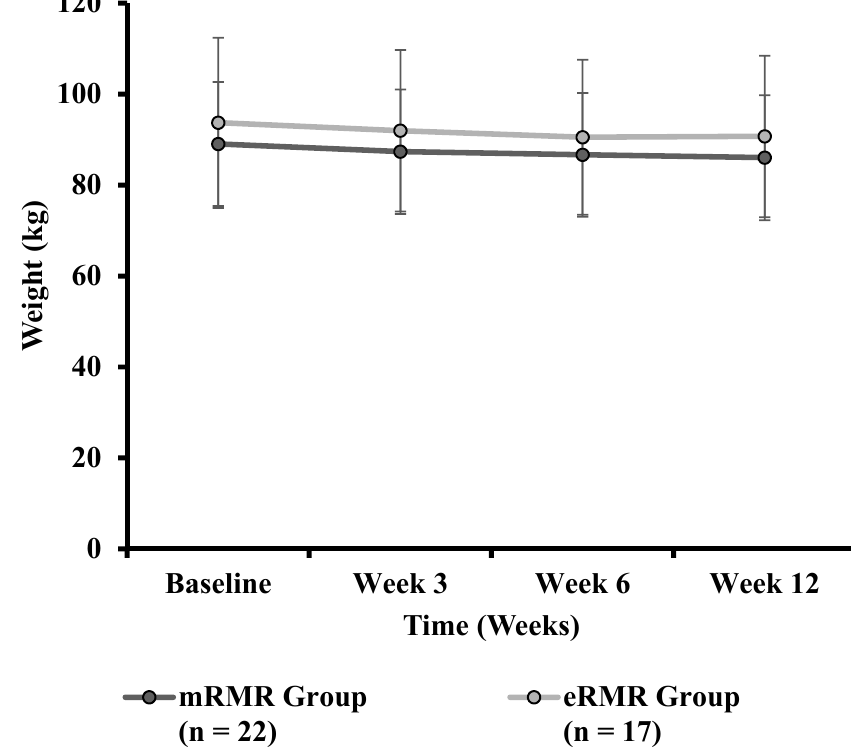
Figure 1. Weight (kg) across the intervention period for the mRMR ( n = 22) and eRMR ( n = 17) groups.